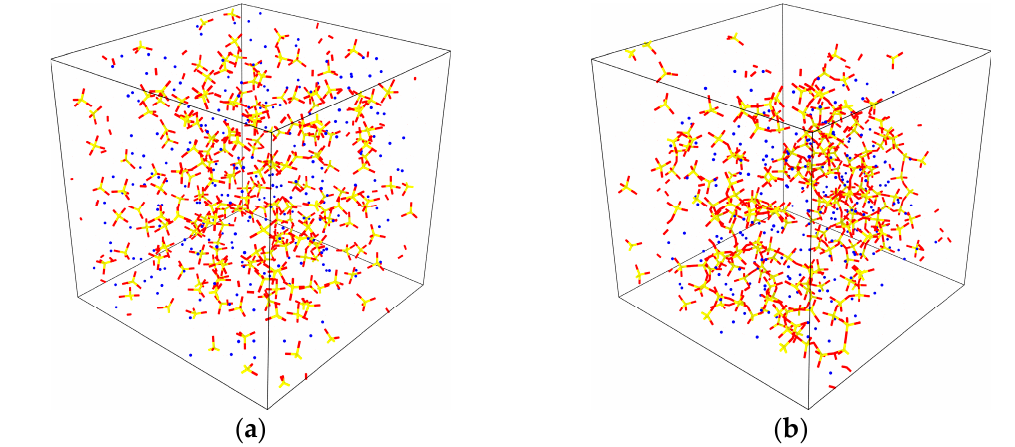
Figure 2. Atomic structures of C-S-H with C/S = 1.1 before ( a ) and after ( b ) reactions at 1500 K. Note: Yellow for silica atoms; red for oxygen atoms; blue for calcium atoms.